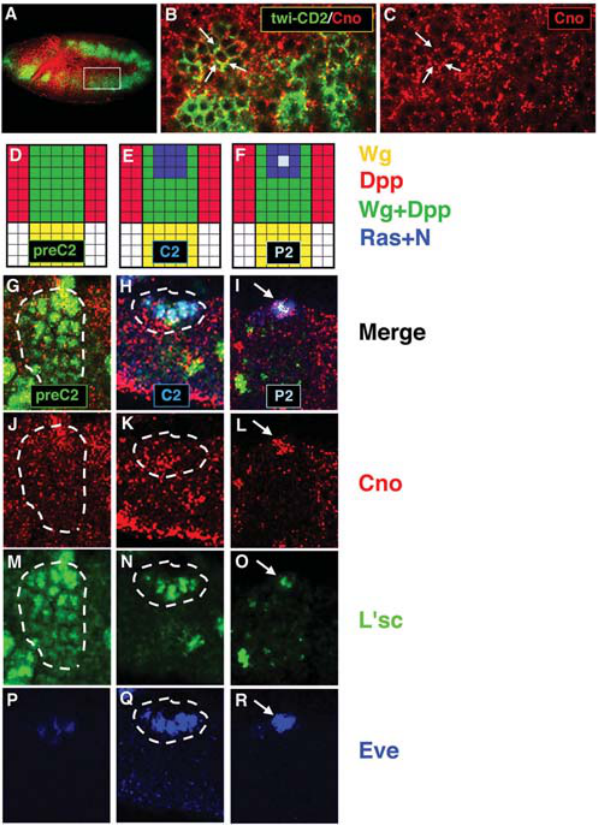
Figure 1. Cno is expressed in the mesoderm throughout progenitor specification. (A) Confocal immunofluorescence showing a lateral view of a late stage 10 embryo. Cno (red) is detected in the mesoderm (green). (B, C) Higher magnification of two hemisegments (63 6 ; inset in A) reveals punctuate Cno expression at submembrane locations (arrows). (D–F) Diagrams show the most dorsal part of one hemiseg- ment and the signals involved throughout dorsal progenitor specifica- tion. (G–R) Confocal immunofluorescences showing high magnification (63 6 ) of the most dorsal part of one hemisegment. (D, G, J, M) Cno is expressed in the dorsal mesodermal region pre-patterned by Wg and Dpp (preC2) along with L’sc. (E, H, K, N, Q) Cno is detected in the equivalence group in which Ras is locally activated (C2) restricting L’sc to this cluster and activating Eve. (F, I, L, O, R) Cno is expressed in the progenitor (P2) singled out from this cluster after N-promoted lateral inhibition.